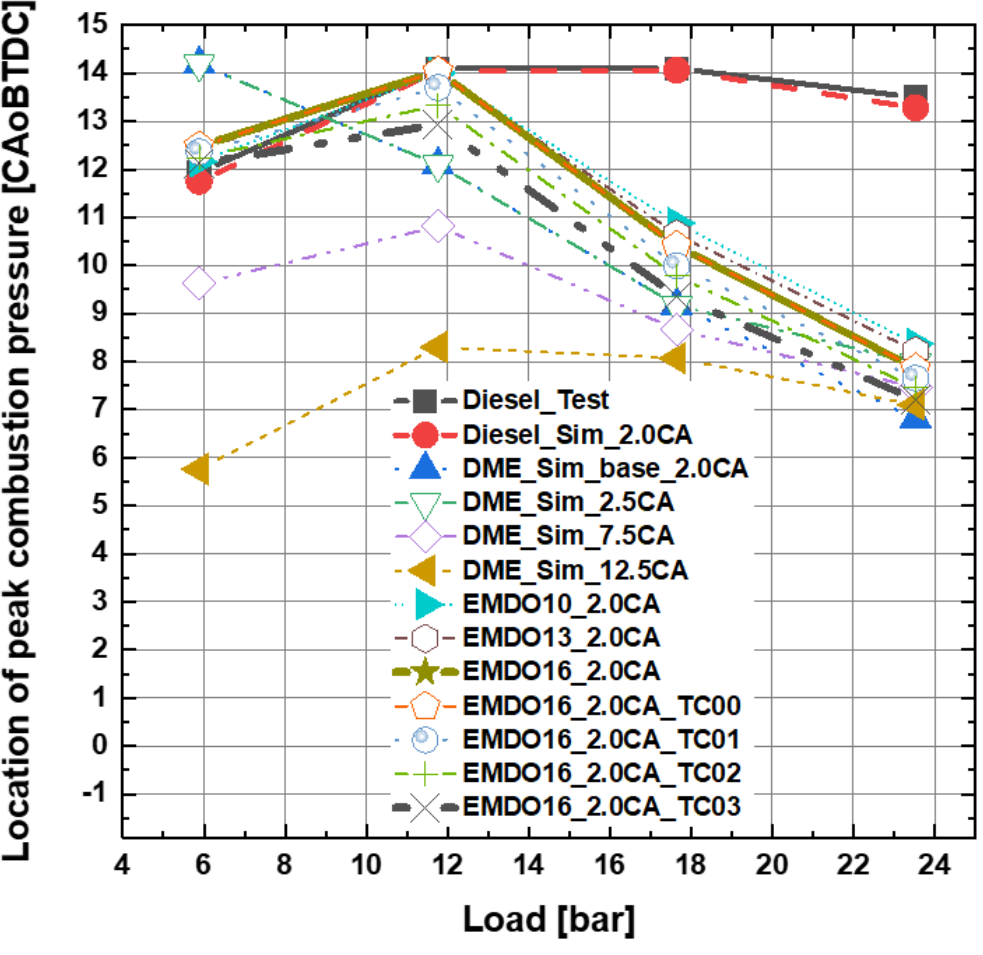
Figure 5. Location of the peak combustion pressure in a cylinder chamber in accordance with MDO, EMDO, and DME fuels.